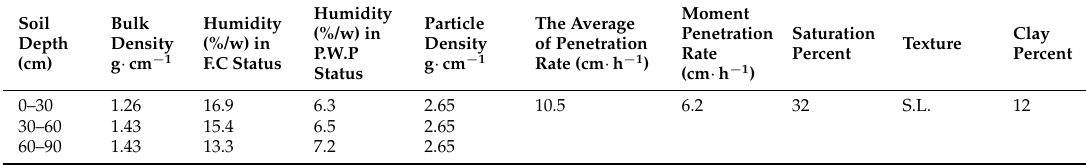
Table 3. Physical characteristics for soil of experimental field before implementation of